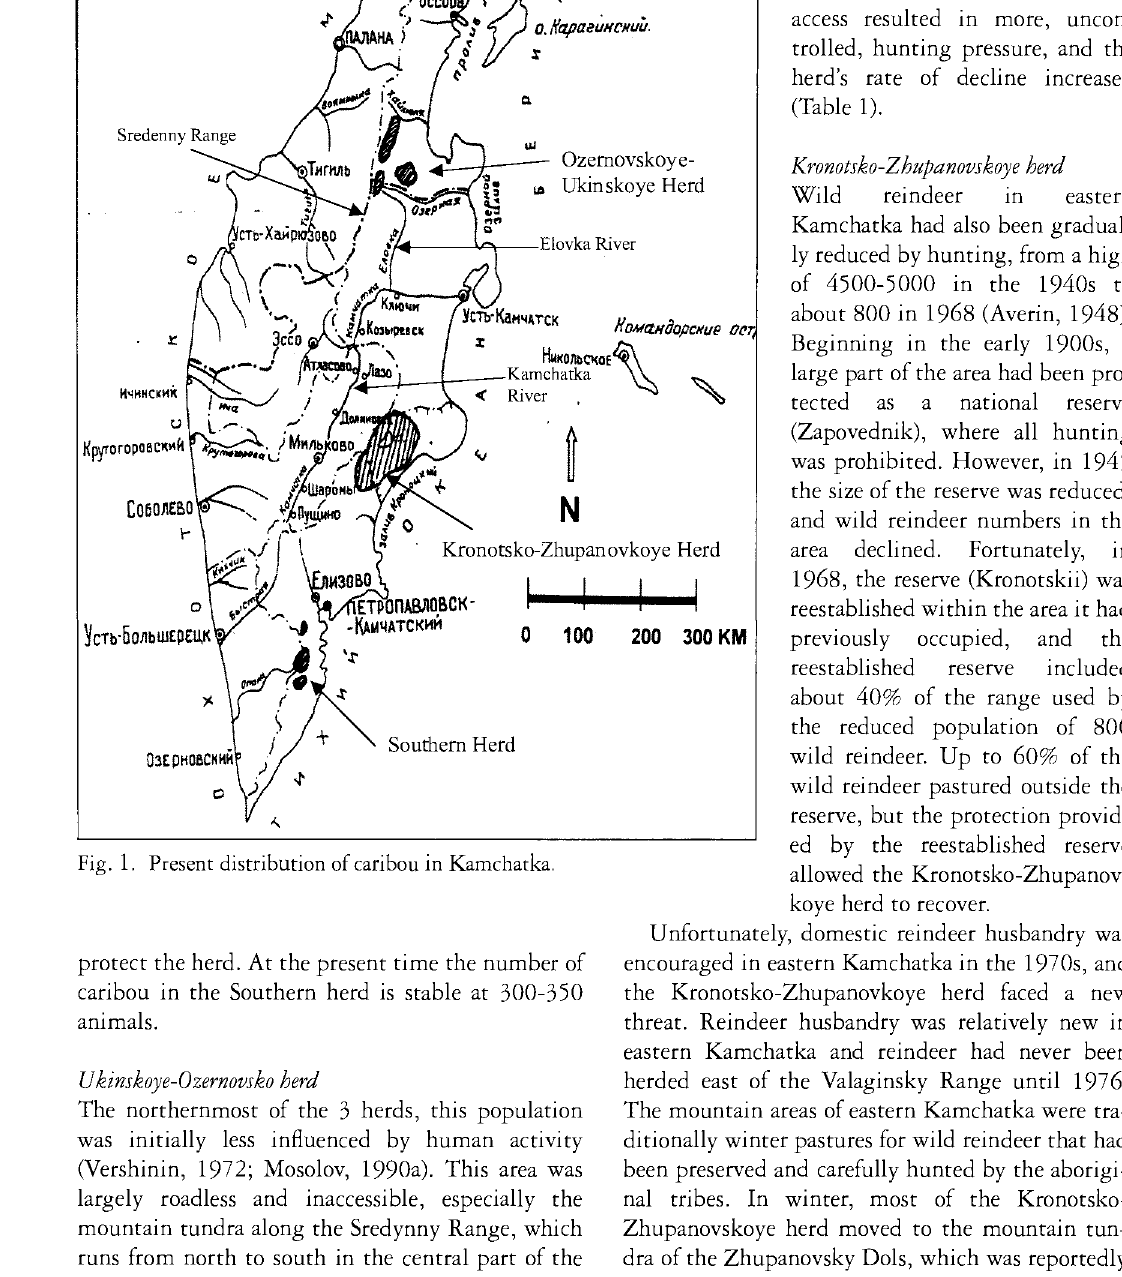
Fig. 1. Present distribution of caribou in Kamchatka.